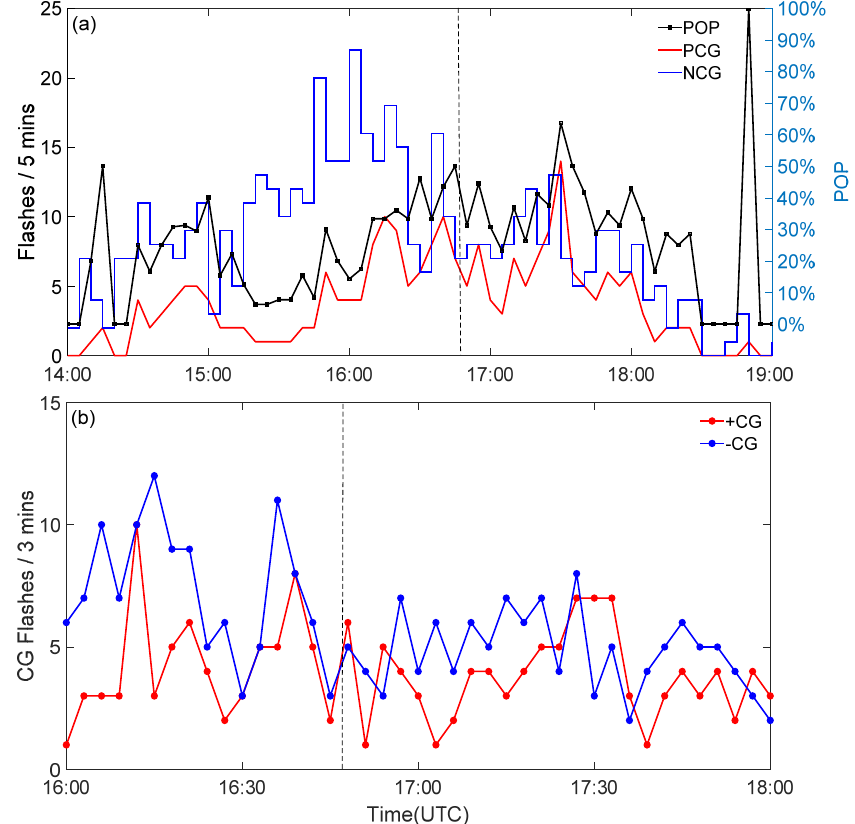
Figure 8. ( a ) Evolution of CG flashes per 5 minutes in the parent thunderstorm. ( b ) CG flashes per 3 minutes about 2 hours before and after the sprite. The black dashed line in ( a ) and ( b ) shows the sprite occurrence time, respectively.